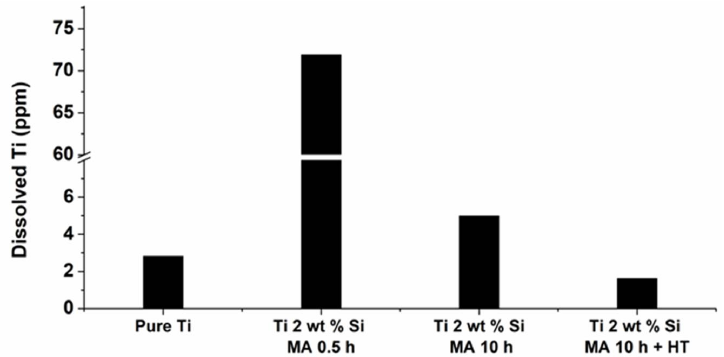
Figure 10. Inductively coupled plasma spectrometry (ICP) analysis for the titanium samples in 1.63 M H 2 SO 4 after the potentiodynamic measurements.